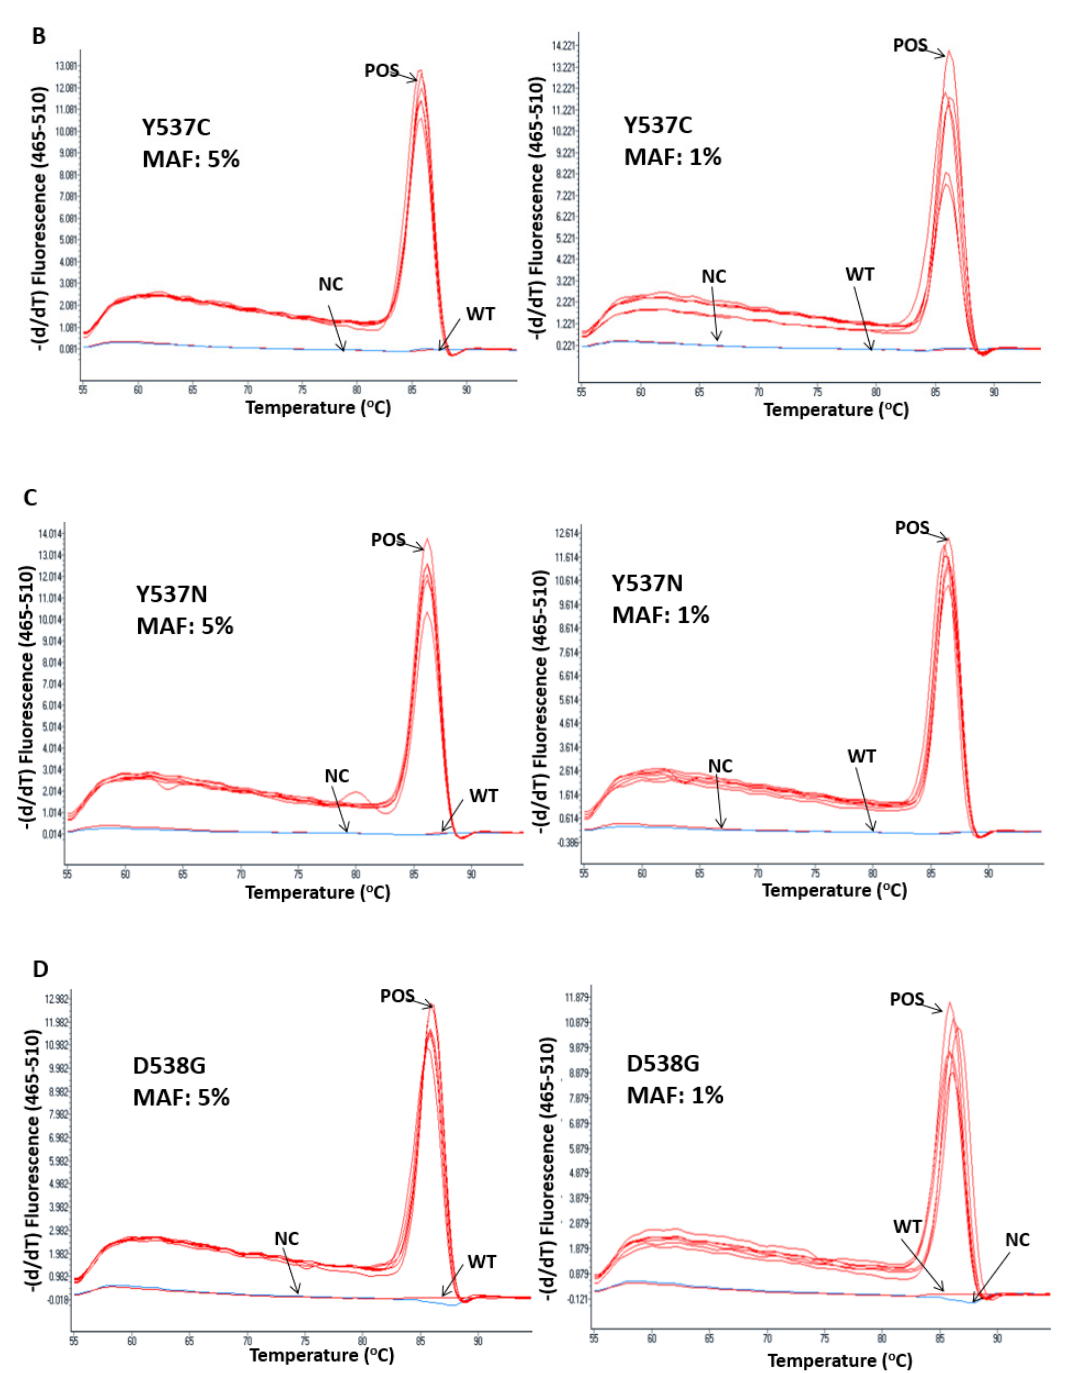
Figure 2. Within-day reproducibility of the ESR1 -NAPA assay using synthetic DNA oligos for D538G, Y537S, Y537C and Y537N mutations at 1% MAF and 5% MAF (five replicates), ( A ) Y537S, ( B ) Y537C, ( C ) Y537N, ( D ) D538G. POS: the positive control was a synthetic oligonucleotide sequence harboring each of the four ESR1 mutations (9% MAF); NC: PCR negative control; WT: wild type. Table 1. Reproducibility of the ESR1 NAPA assay using synthetic oligos for each ESR1 mutation.